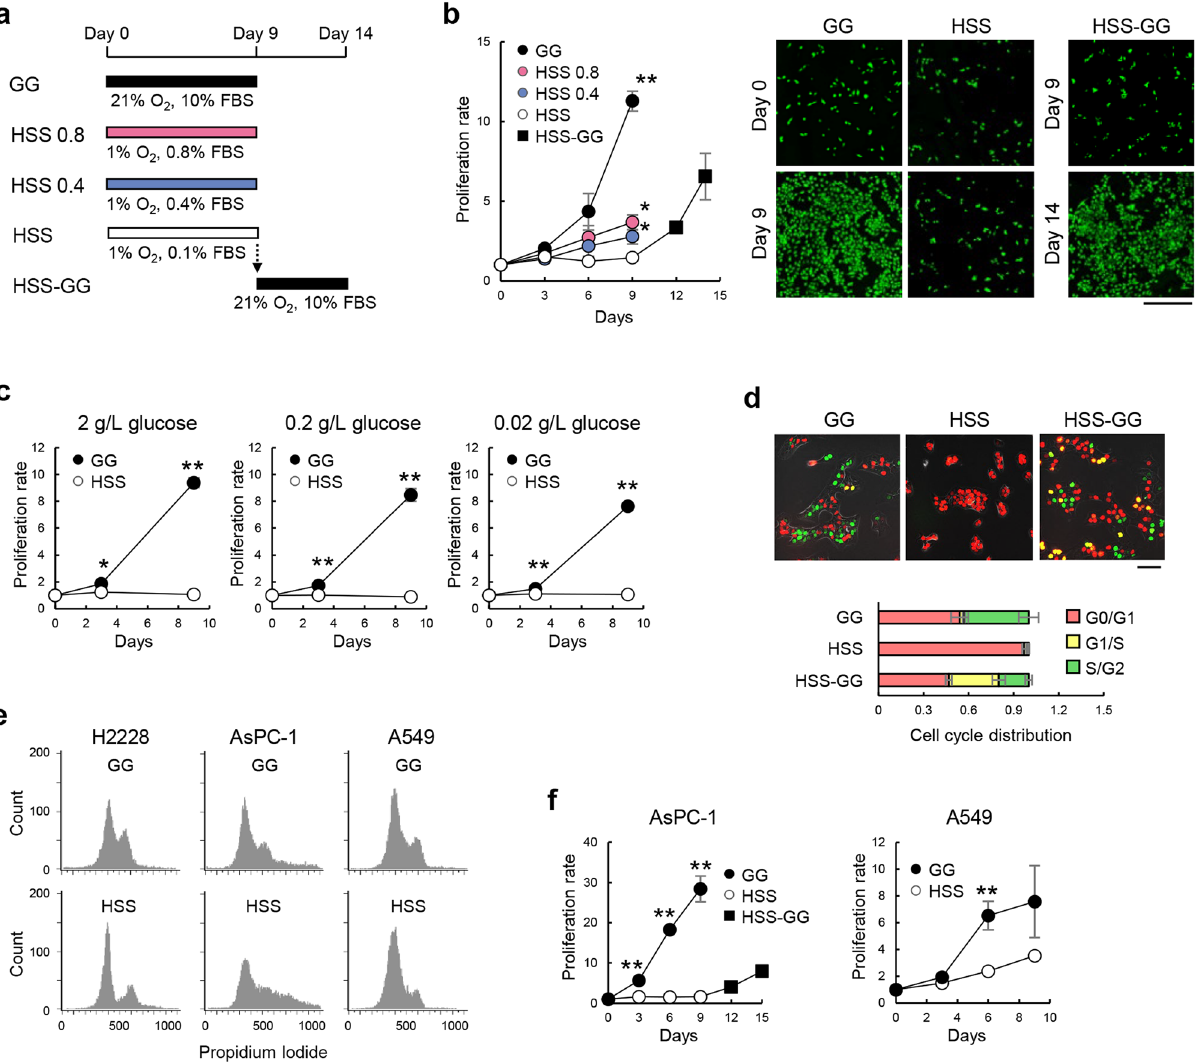
Figure 1. H2228 and AsPC-1 cells were induced to a reversible quiescent state. ( a ) Schematic representation of the cell culture conditions. ( b ) Proliferation of H2228 cells under GG and HSS conditions. Proliferation rates (left) and representative fluorescent micrographs (right) are shown. The living cells were fluorescently labeled with CellTracker Green CMFDA. ( c ) Proliferation of H2228 cells under GG and HSS conditions at different glucose concentrations. Proliferation rates are shown. ( d ) Cell cycle phase of H2228 under GG and HSS conditions. Representative fluorescent micrographs of H2228/fluorescent ubiquitination-based cell cycle indicator (FUCCI) cells (top) and cell cycle distribution (bottom) are shown. ( e ) Cell cycle analysis by quantitation of DNA content of H2228, AsPC-1, and A549 under GG and HSS conditions. Representative flowcytometric histograms after DNA staining with propidium iodide are shown. ( f ) Proliferation of AsPC-1 and A549 cells under GG and HSS conditions. Proliferation rates are shown. ( a, b, c, d, e, f ) GG, general growth conditions; HSS 0.8, hypoxic and serum-starved (1% O 2 and 0.8% FBS) conditions; HSS 0.4, hypoxic and serum-starved (1% O 2 and 0.4% FBS) conditions; HSS, hypoxic and serum-starved (1% O 2 and 0.1% FBS) conditions; HSS-GG, GG conditions after HSS conditions; FBS, fetal bovine serum. ** p < 0.01 (versus GG), * p < 0.05 (versus GG). Scale bar: 500 μm, n =